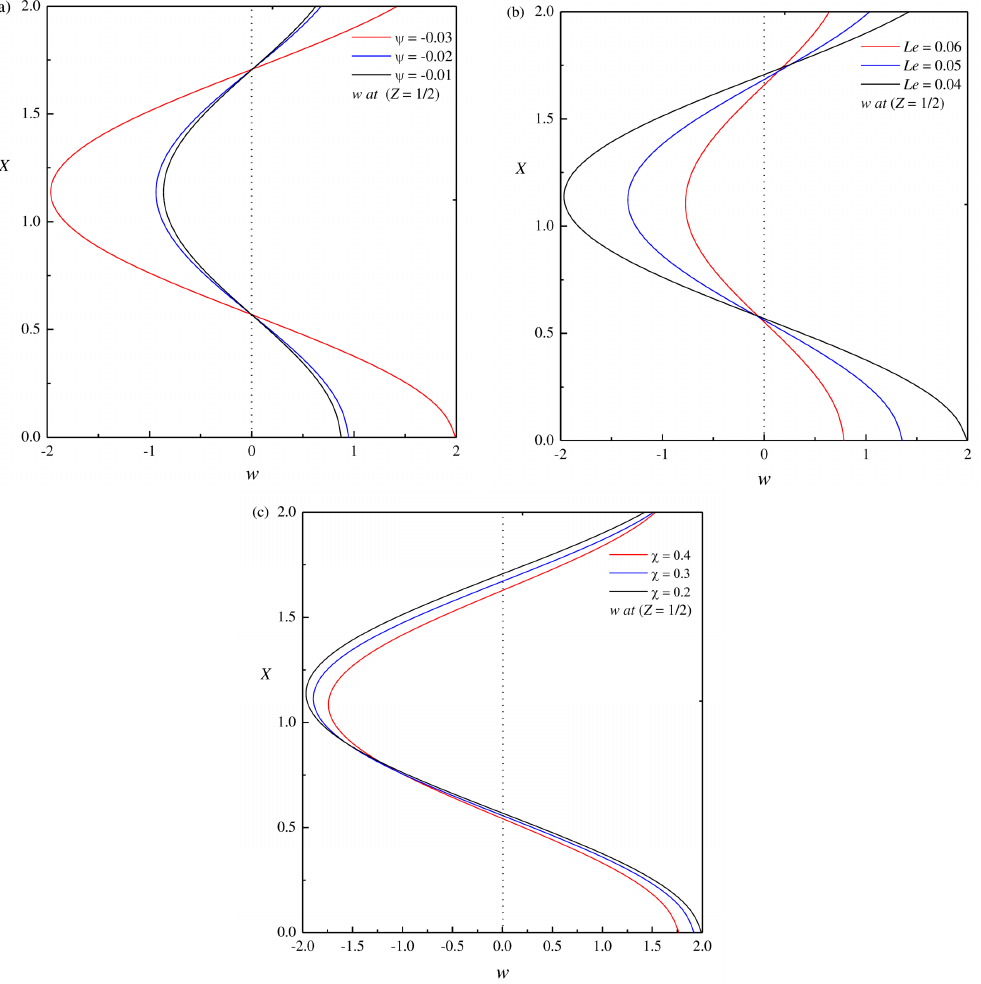
Figure 1. Variation of θ and ( b ) R = 3 R co .